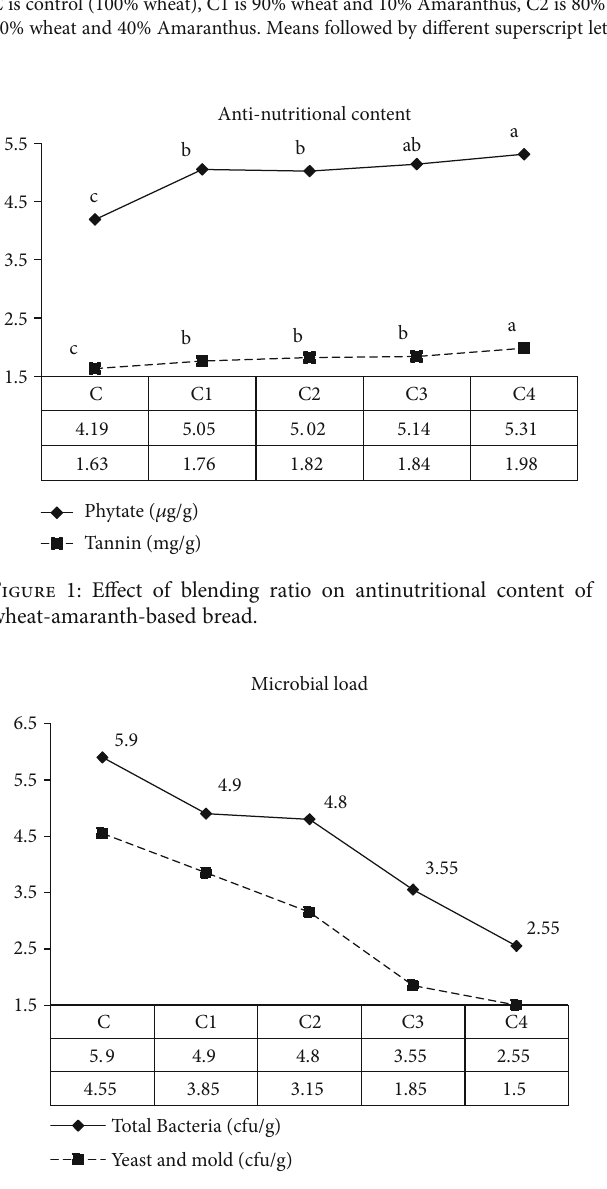
Figure 2: E ff ect of blending ratio on microbial load (total plate count, mold, and yeast) of wheat-amaranth